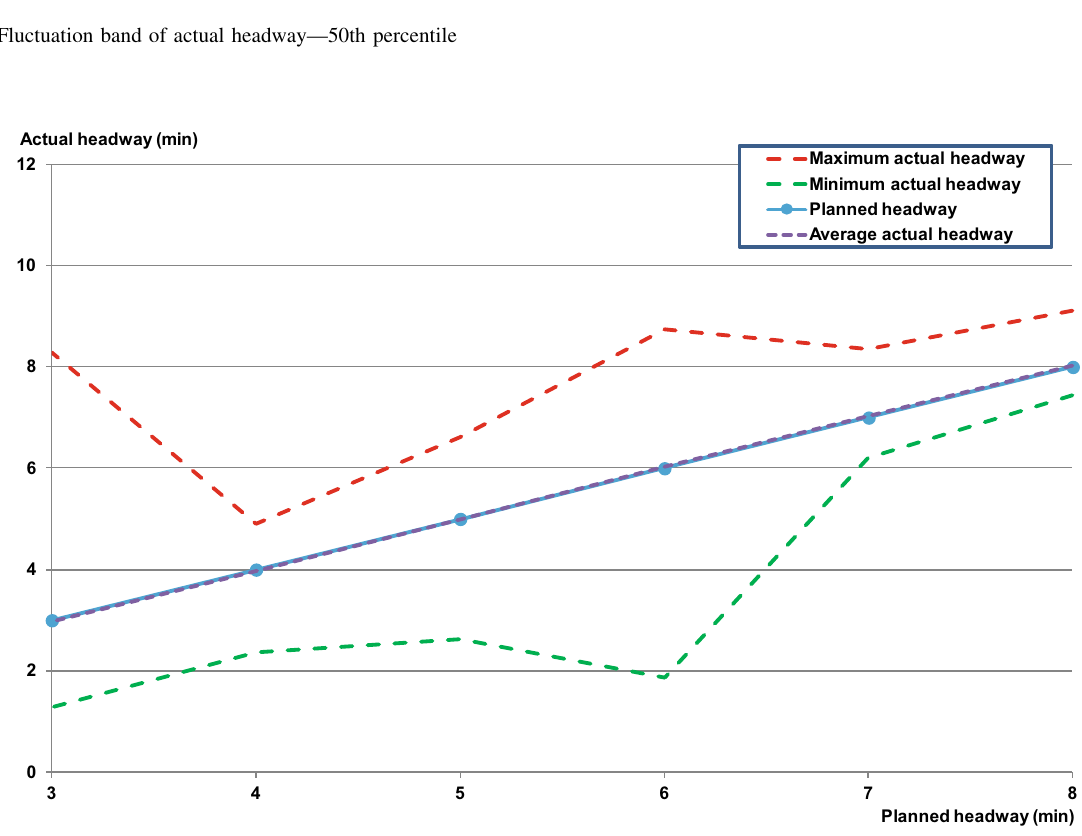
Fig. 7 Fluctuation band of actual headway—50th percentile